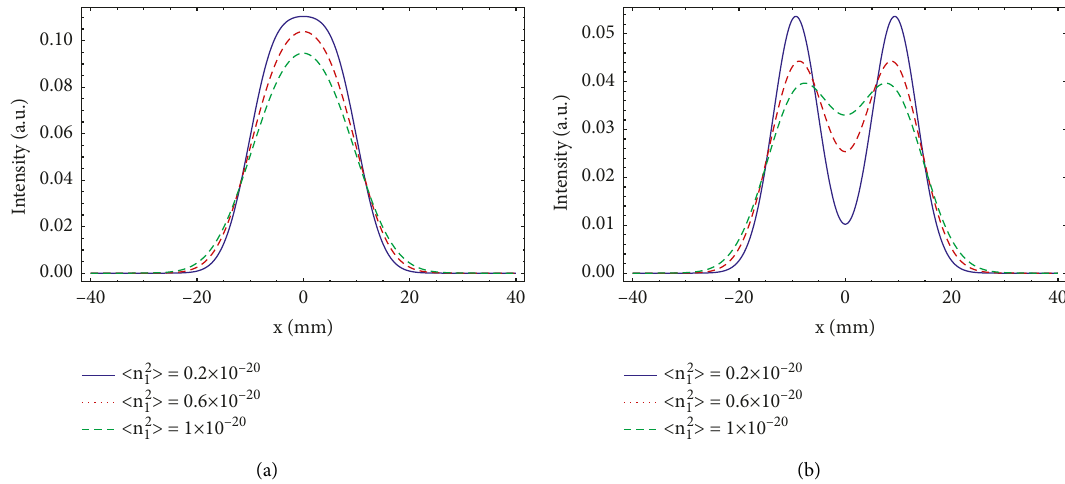
Figure 5: Cross-sections of the intensity distribution of the partially coherent circular: (a) flat-topped nonvortex beam and (b) flat-topped vortex hollow beam in anisotropic turbulent plasma for different values of the refractive index fluctuation variance